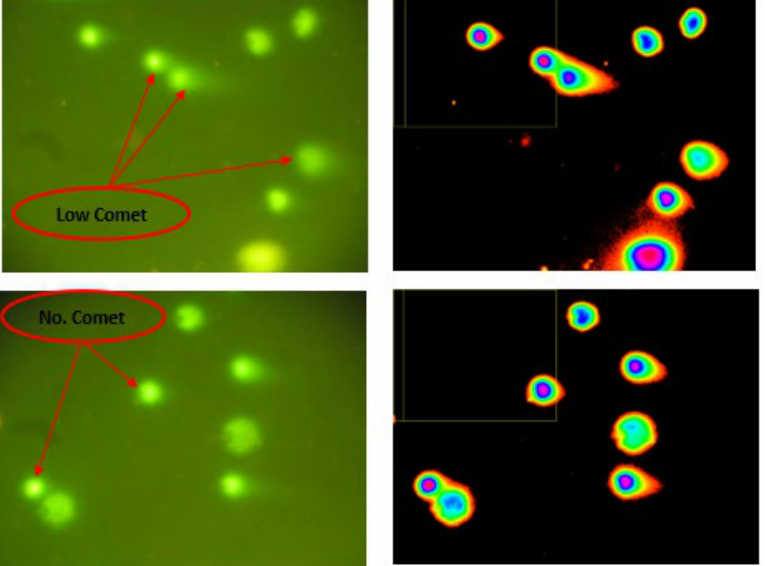
Figure 9. Control group (negative): high numbers of cells with low comet and no comet by using comet score program.